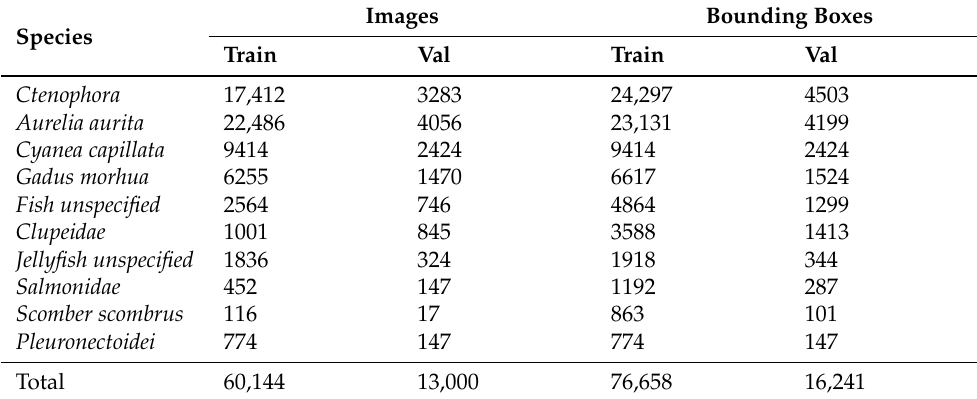
Table 2. The amount of images and bounding box annotations per category, as contained in the training and validation